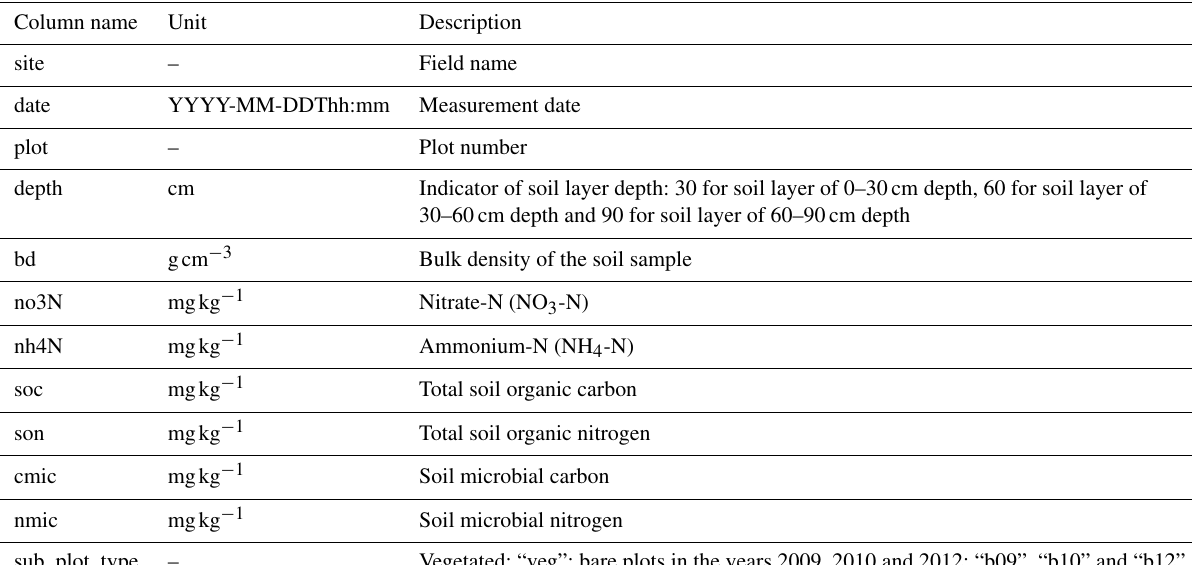
Table 8. Determined variables and description of the soil carbon and nitrogen measurement files (soil_cn.csv).